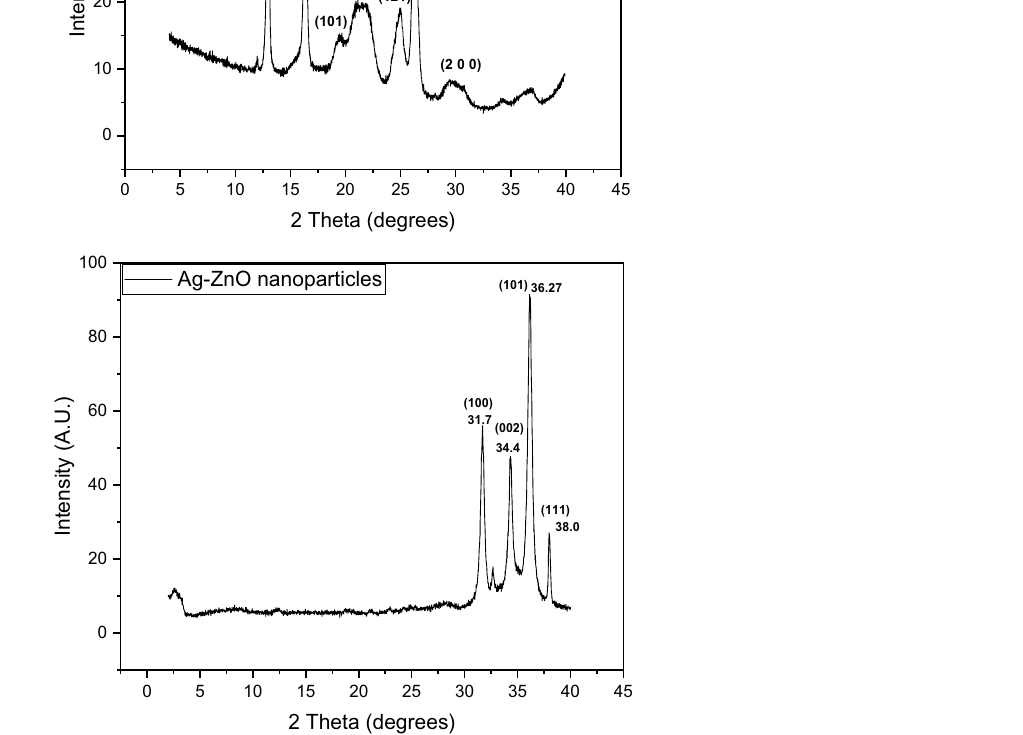
Figure 3. XRD of neat PHBV and Ag–ZnO